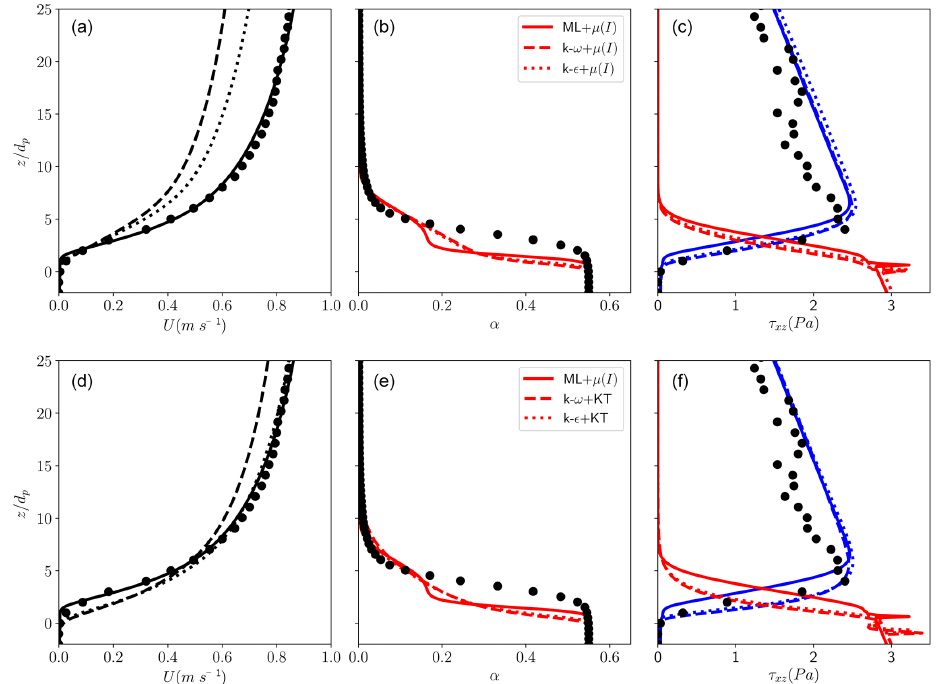
Figure 3. Comparison of two-phase numerical results with experiments of Revil-Baudard et al. (2015) (black symbols) in terms of volume- averaged velocity profiles (black lines) in the left column of panels, sediment concentration (red lines) in the center column of panels, and Reynolds shear stress (blue lines) and granular stress (red lines) in the right column of panels, using the dense granular-flow rheology ( µ(I) ) with the three turbulence models (mixing length, ML; k − ω ; and k − ε ) in (a, b, c) and the kinetic theory of granular flows (KT) with the three turbulence models (mixing length, ML, k − ω , and k − ε ) in (d, e, f) . The values of the different numerical and physical parameters are reported in Table